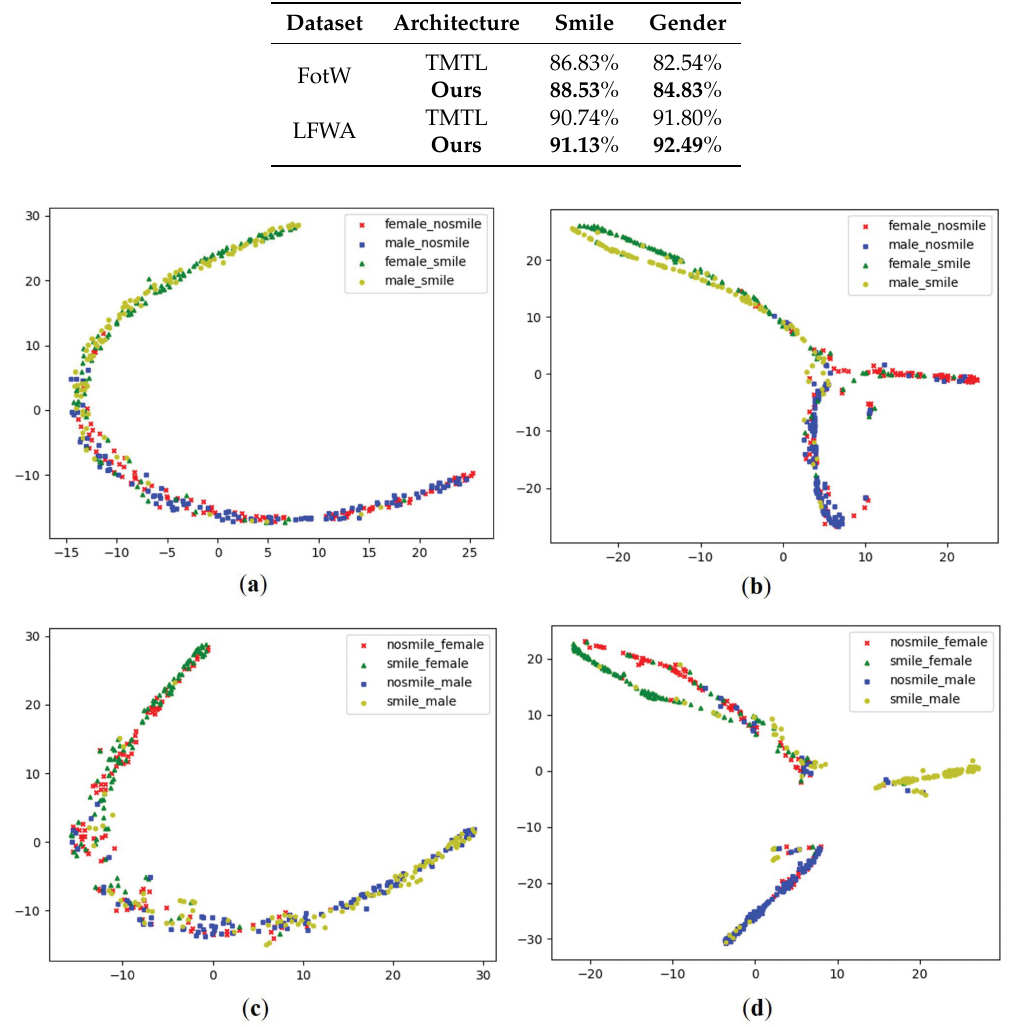
Figure 5. t-SNE visulization on the sampled FotW validation dataset. ( a ) t-SNE visualization of FC S ; ( b ) t-SNE visualization of FC S | C ; ( c ) t-SNE visualization of FC G ; ( d ) t-SNE visualization of FC G | C G